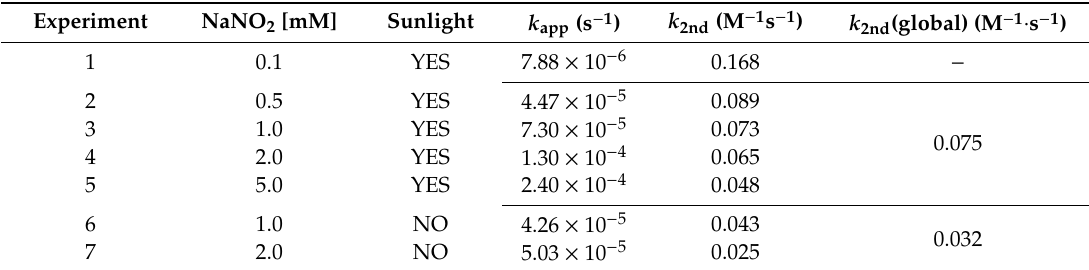
Table 2. Kinetic rate constants (apparent pseudo-first-order, k app ; second-order, k 2nd ; and global second-order, k 2nd (global)) of the photolysis of 3-methylcatechol (3MC) in aqueous solution (pH = 4.5–5, T = 25 °C) at different initial concentrations of NaNO 2 under simulated sunlight conditions (YES) and in the dark (NO). The initial concentration of 3MC was always 0.1 mM.